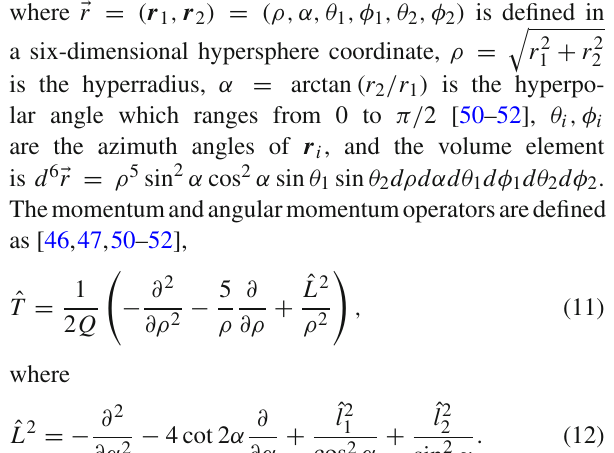
x i − x j . The potentials between (cid:3) - N and (cid:3) - (cid:3) are the fit where (cid:5) r = ( r 1 , r 2 ) = (ρ, α, θ 1 , φ 1 , θ 2 , φ 2 ) is defined in